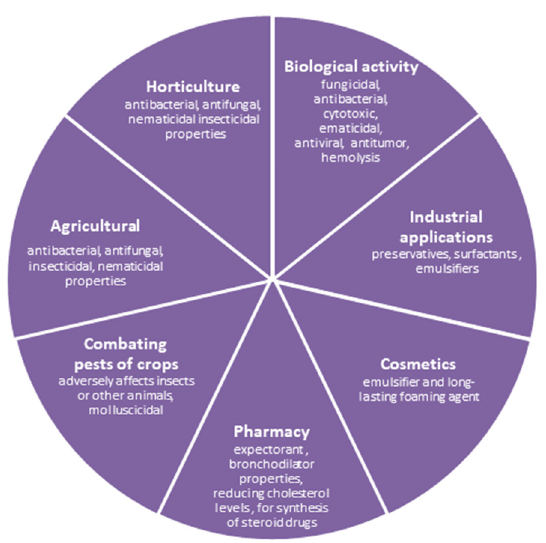
Figure 2. Applications of saponins due to their physicochemical and biological properties as well as their featured structural diversity.